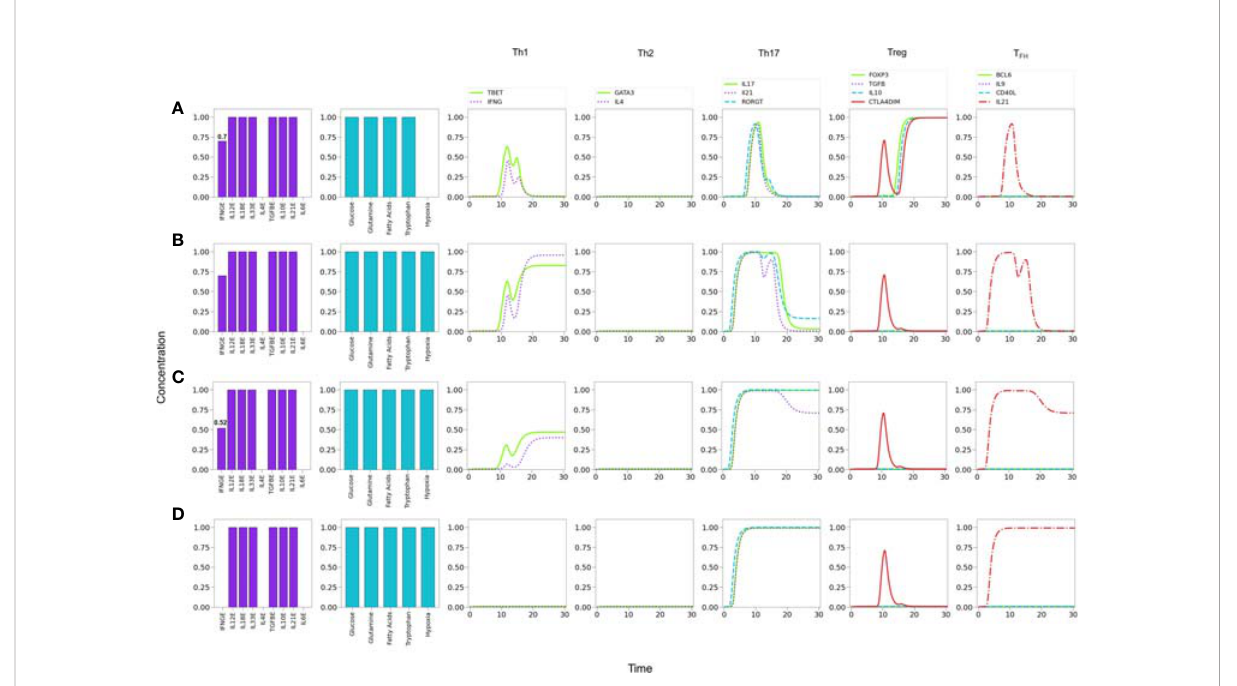
FIGURE 11 Effects of IFN- g and oxygen de fi ciency in a microenvironment de fi ned by Th1-, Th17-, and Treg-inducing cytokines. (A) Depletion of IFN- g in absence of hypoxia inhibits Th1 expression and induces a Treg phenotype at a critical value IFN- g = 0.7. A transient expression of Th17 is also observed. (B) In the former conditions (IFN- g = 0.7), the action of hypoxia re-boosts Th1 and downregulates Treg, inducing a low-level expression of Th17. (C) A further decrease of IFN − g (0.52) in conjunction with hypoxia downregulates Th1 polarization and potentiates Th17 expression. (D) Null levels of IFN- g together with hypoxia leads to total elimination of the Th1 phenotype and a robust expression of